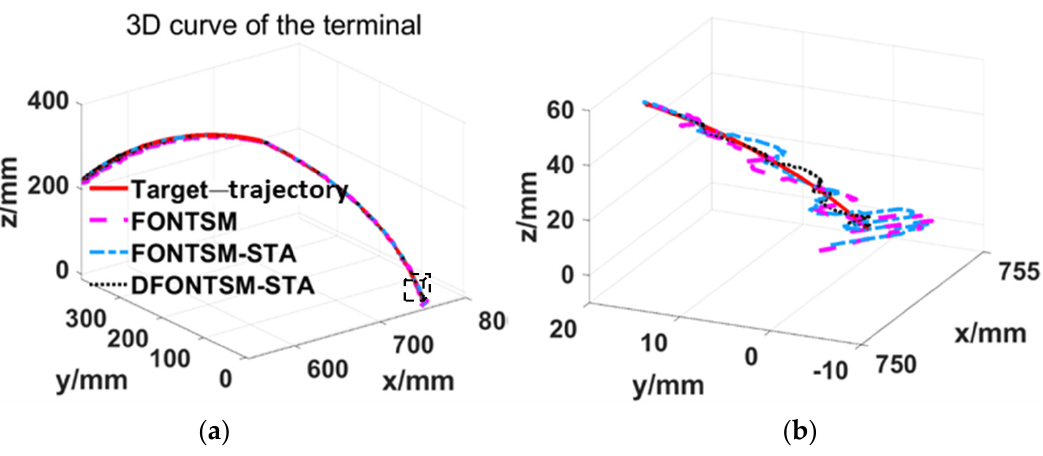
minal tracking error on the Z axis.